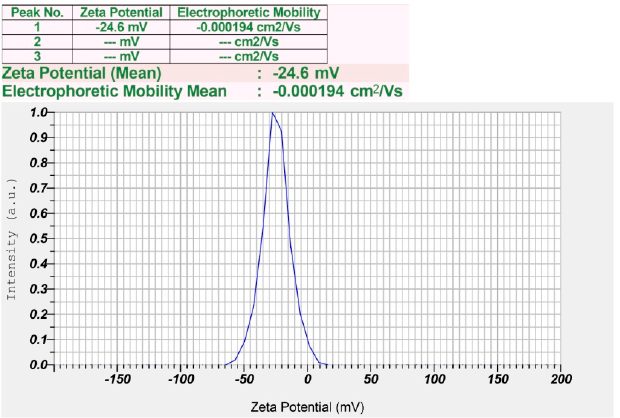
Figure 9. Zeta potential analysis of synthesized P-AgNPs from leaf extract of P. alba .